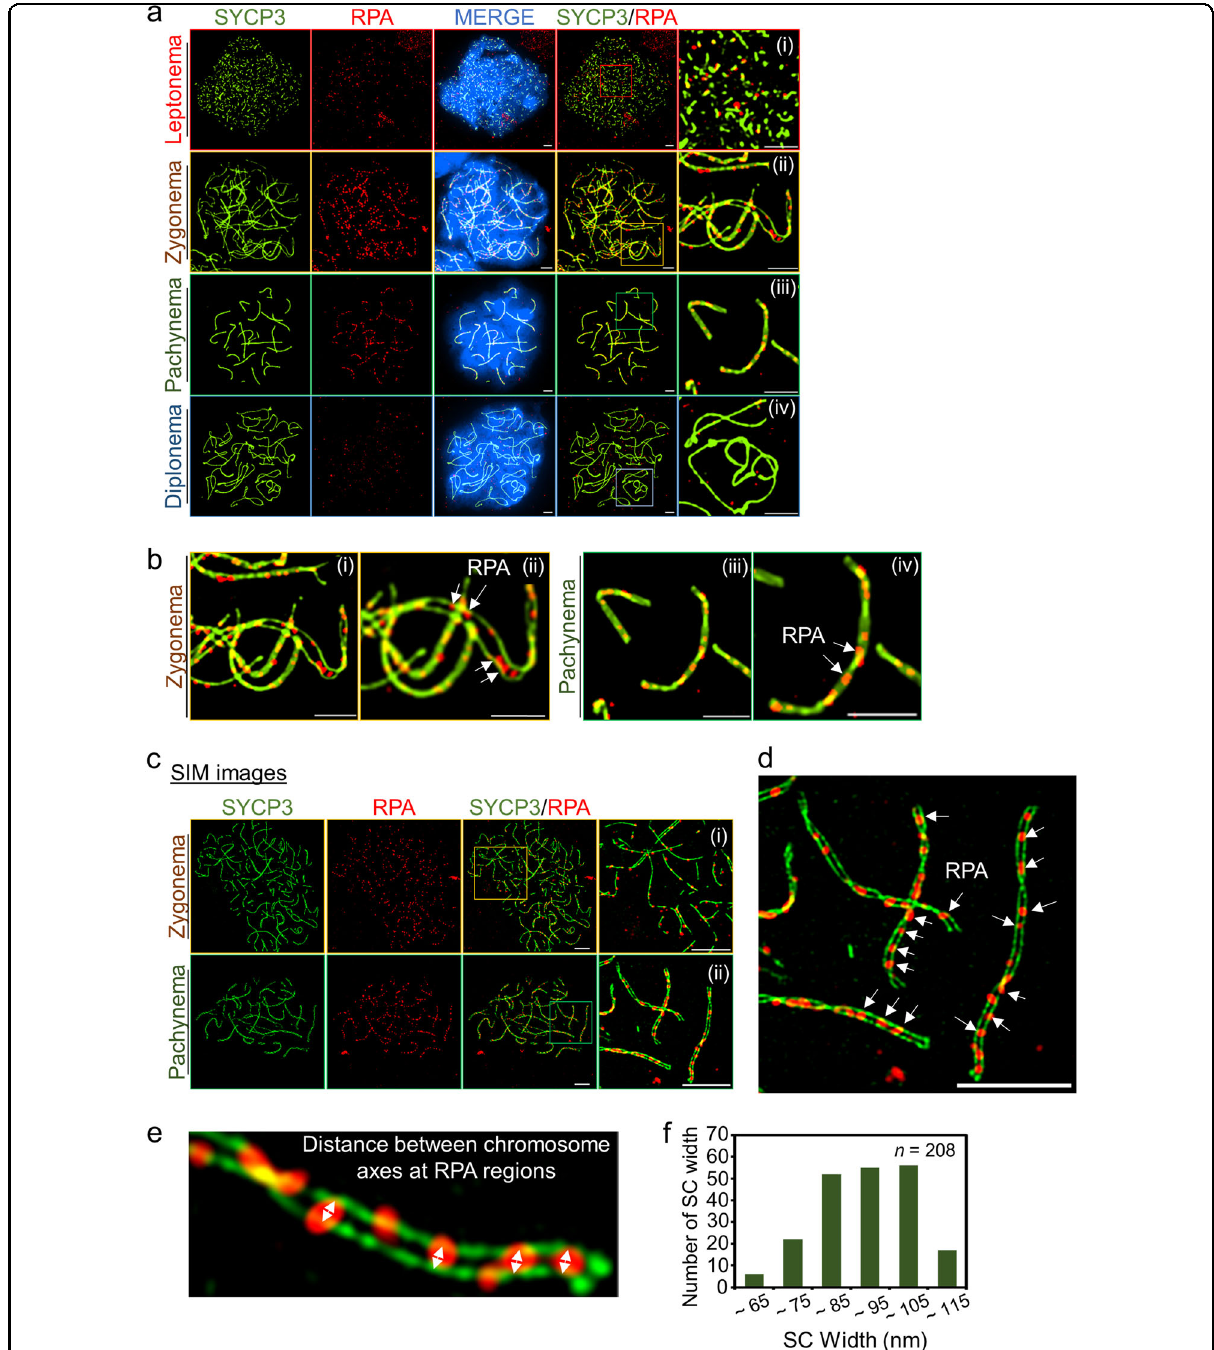
Fig. 5 Distribution of replication protein A foci in prophase I. a RPA localization in leptonema (i), zygonema (ii), pachynema (iii), and diplonema (iv). The images were acquired via conventional fl uorescence microscopy. Bars represent 2.5 μ m. b Chromosome structures stained with anti-RPA and anti-SYCP3 antibodies. The images showing zygonema and pachynema chromosomes were magni fi ed with overlay ( a ). White arrows indicate RPA foci. Bars represent 2.5 μ m. c Super-resolution microscopy images of SYCP3 and RPA. Distribution of RPA on chromosomes was observed via SIM. Spermatocytes were stained with anti-RPA (red) and anti-SYCP3 (green) antibodies, and immuno fl uorescence images were acquired using SIM. (i) zygonema and (ii) pachynema. Bars represent 2.5 μ m. d Overlay of magni fi ed image at the pachynema stage. The image is enlarged from c (ii). White arrows represent RPA foci. Bars represent 2.5 μ m. e Representative images showing chromosome axes and RPA foci. The arrows indicate the width of SCs at RPA-binding regions. f Quanti fi cation of distance between chromosome axes with RPA